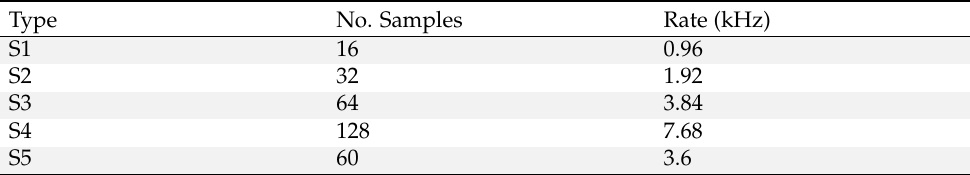
Table 3. Types of sampling rate.